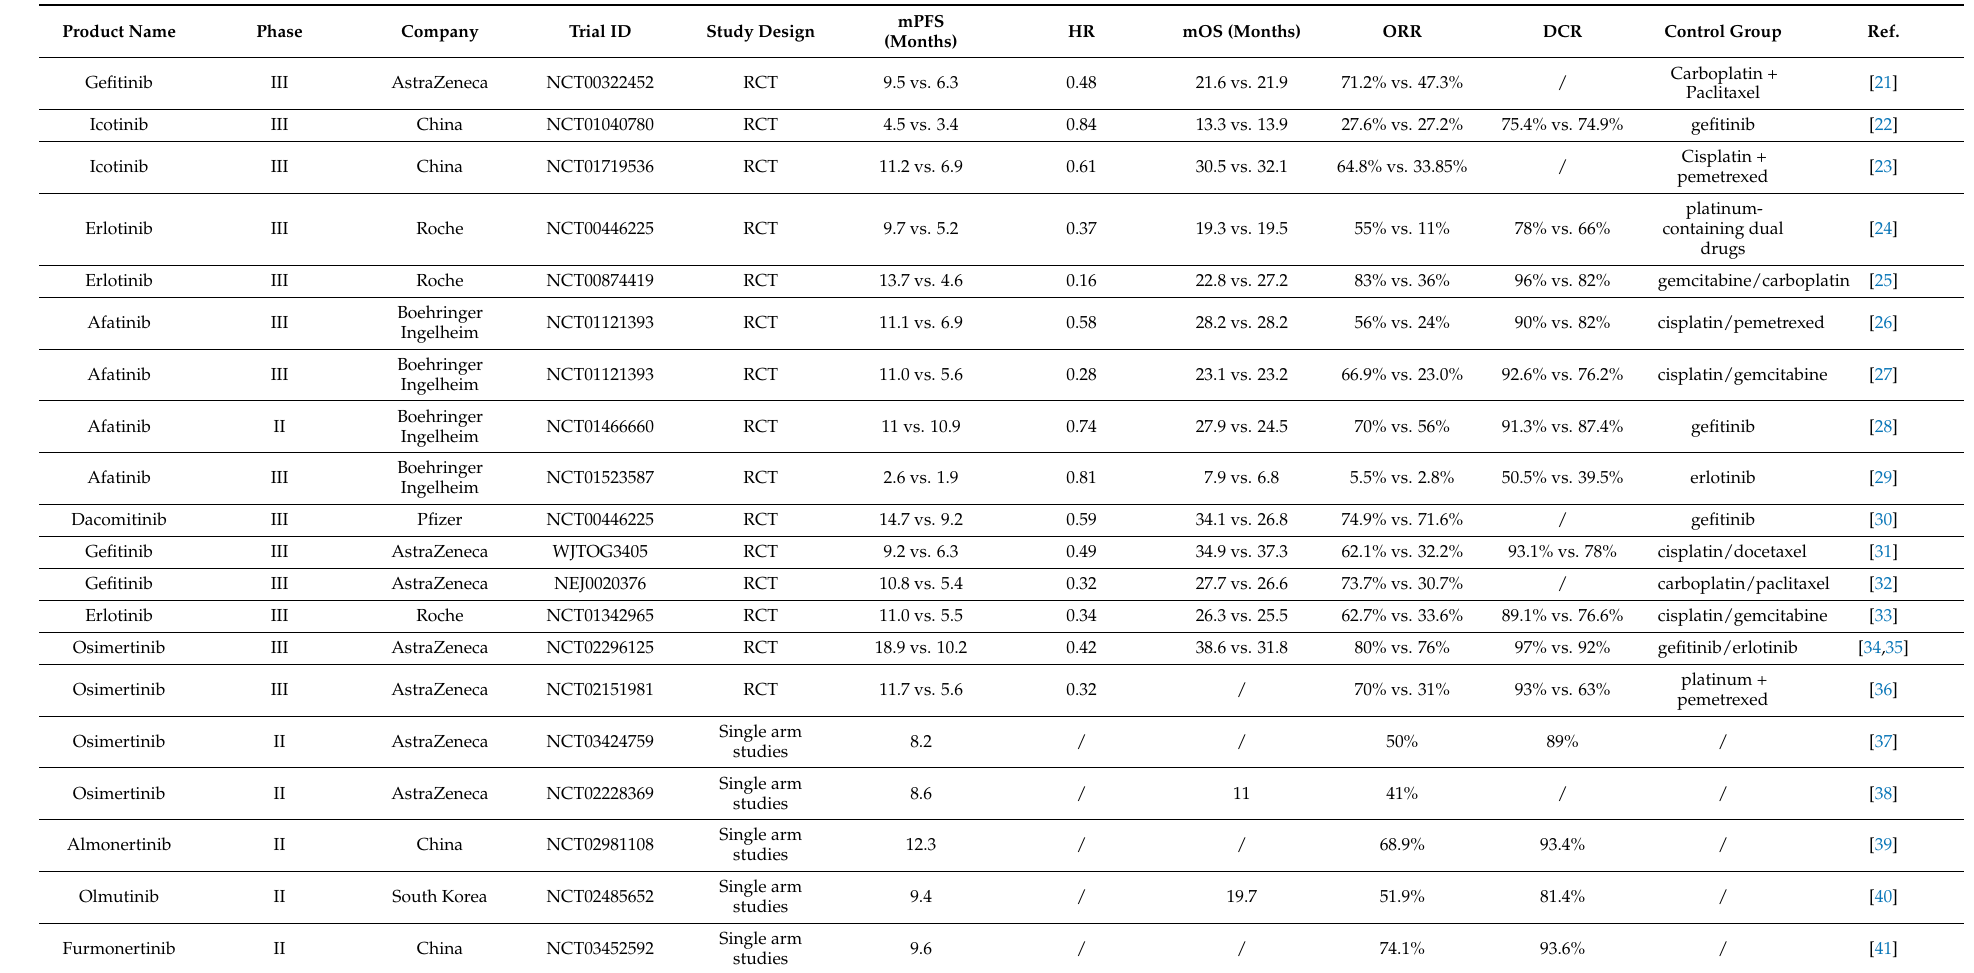
Table 1. Clinical progress of first-/second-/third-generation